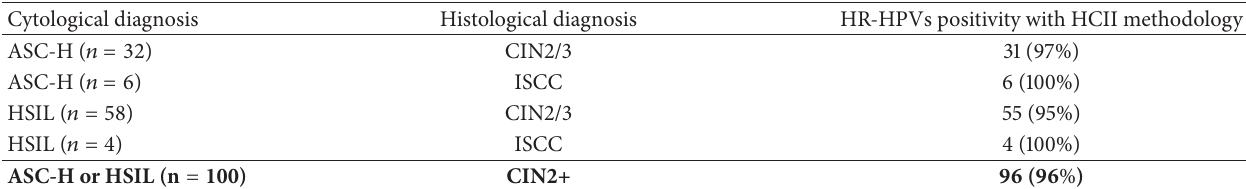
Table 1: Correlations between cytological and histological diagnosis and HR-HPVs positivity with HCII